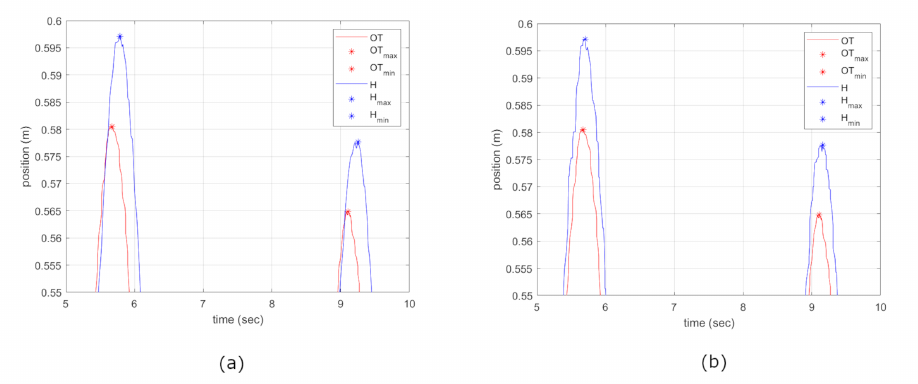
Figure 9. Comparison between original and synchronized data: ( a ) Original data. ( b ) Synchro- nized